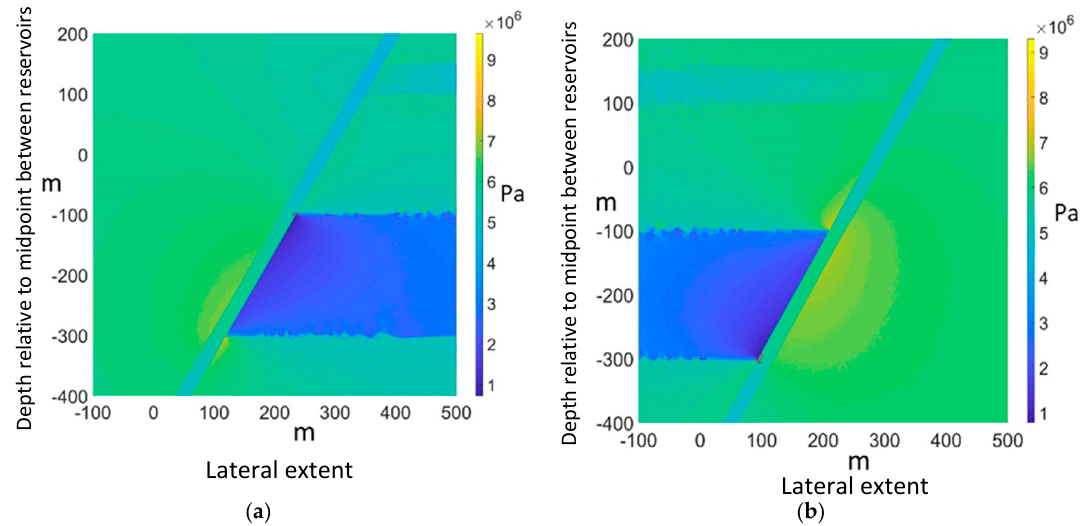
Figure 7. ( a ) For reservoirs in the hanging wall, no shear fracture is seen to propagate up along the fault, even when the pore pressure reaches 17 MPa (11 MPa initial pore pressure). The failed elements are shown in red; ( b ) For reservoirs in the footwall, the picture is reversed, with a handful of fractures appearing at the lower reservoir ʹ s top corner. Effective horizontal stress is plotted, scale in Pa.